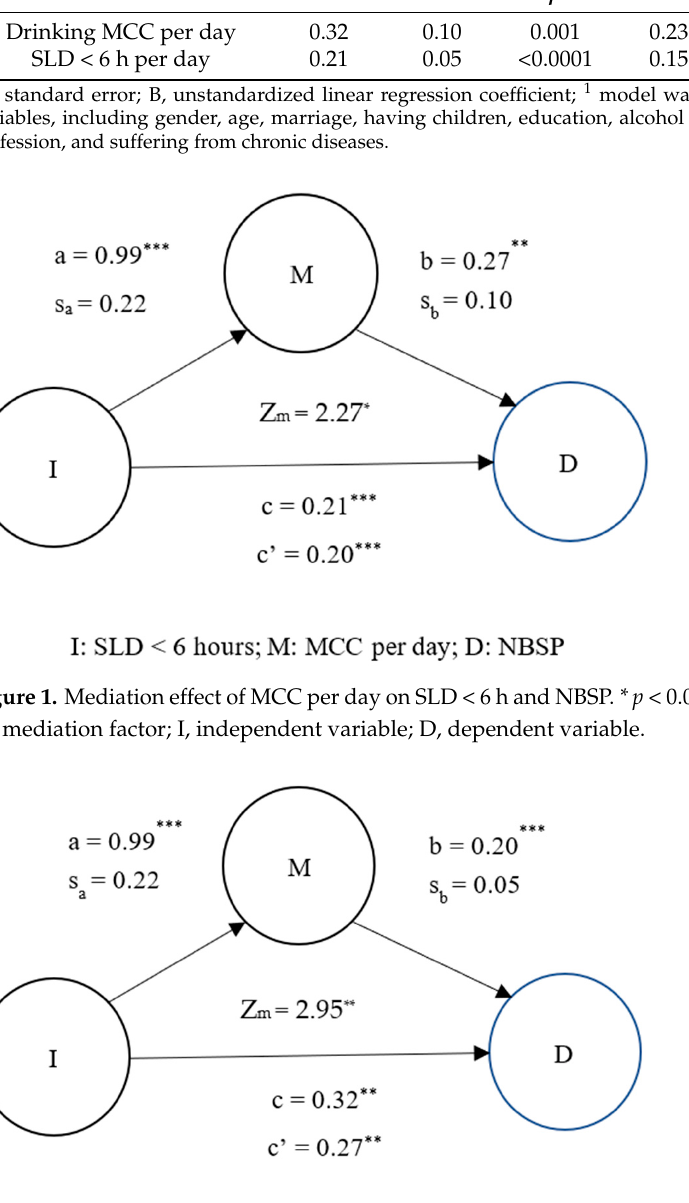
Figure 3. Mediation effect of MCC per day on NBSP and SLD < 6 h. * p < 0.05; ** p < 0.01; *** p < 0.0001; M, mediation factor; I, independent variable; D, dependent variable; c is the simple linear or logistic regression coefficient for the independent variable against dependent variable in the absence of mediation factor; c’ is the binary linear or logistic regression coefficient for the independent var- iable against dependent variable in the presence of mediation factor; 𝑎 is the simple linear or lo- gistic regression coefficient for the independent variable against the mediation factor; 𝑏 is the re- gression coefficient for the mediation factor against the dependent variable in the binary linear or logistic regression model; 𝑠 (cid:3028) and 𝑠 (cid:3029) represent the standard deviations of 𝑎 and 𝑏 . 4. Discussion The present study confirms three hypotheses and determined that long-term heavy coffee intake (two cups per day) and a shorter sleep duration (<6 h per day) are associated with neck and shoulder pain. Notably, long-term heavy coffee intake plays a mediating factor in the vicious circle between shorter sleep duration and neck and shoulder pain. In addition, alcohol use, the lack of regular exercise at least once a week, overtime work in a month, and the presence of chronic diseases were significantly associated with pain in the neck/shoulders or ankles.